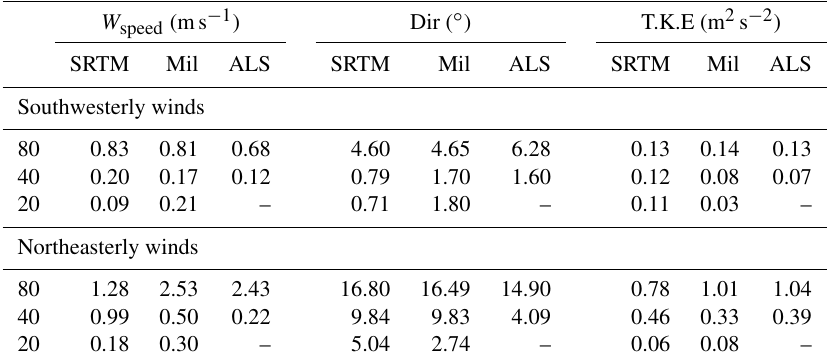
Table 7. RMSE of wind speed, wind direction and turbulent kinetic energy for tower 20/tse04.